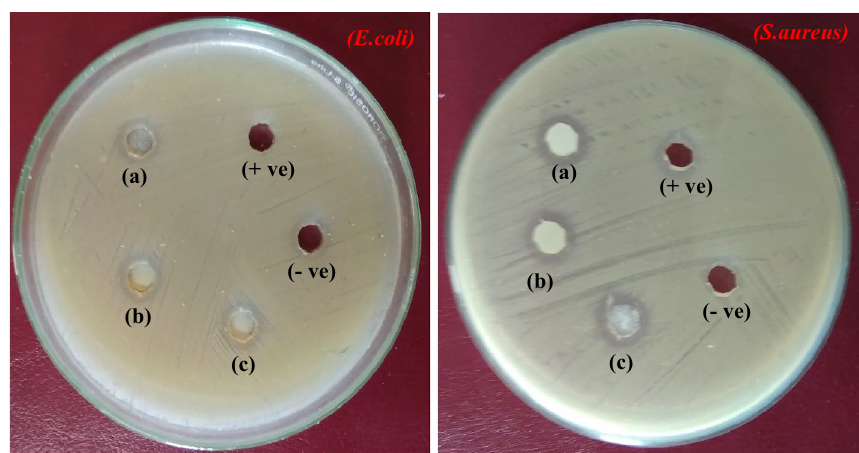
Fig. 15 Zone of inhibition test for 100 µL of (a) SnO 2 , (b) 2% Y-doped SnO 2 NPs and (c) 4% Y-doped SnO 2 NPs towards E. coli and S. aureus bacteria